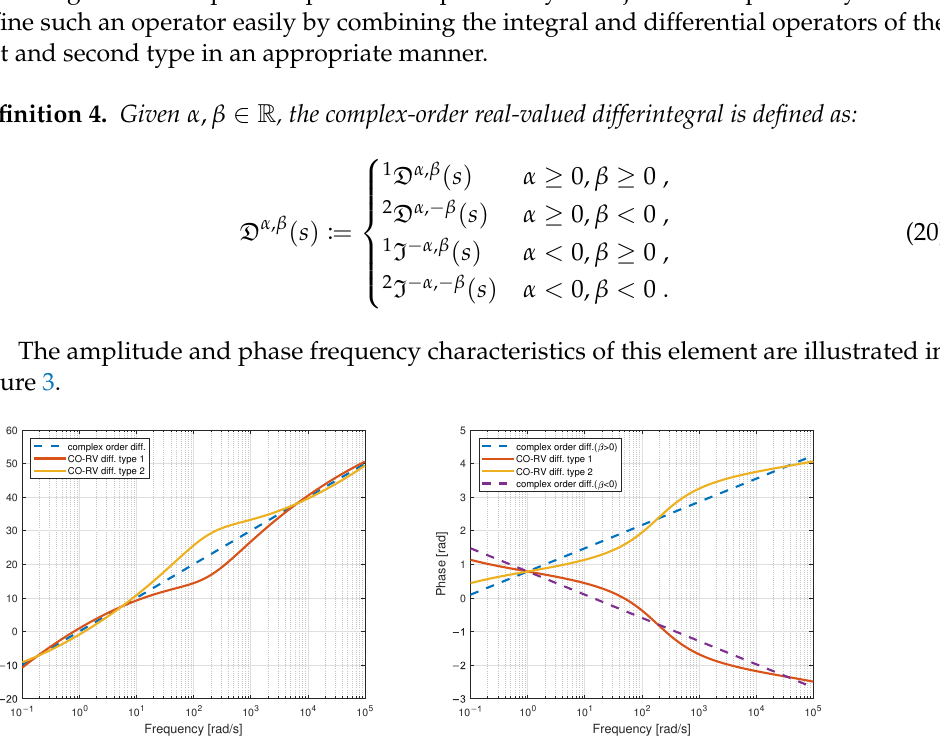
Figure 3. Amplitude ( left ) and phase ( right ) frequency response of a complex-order differentiator with α = 0.5 and β = ±